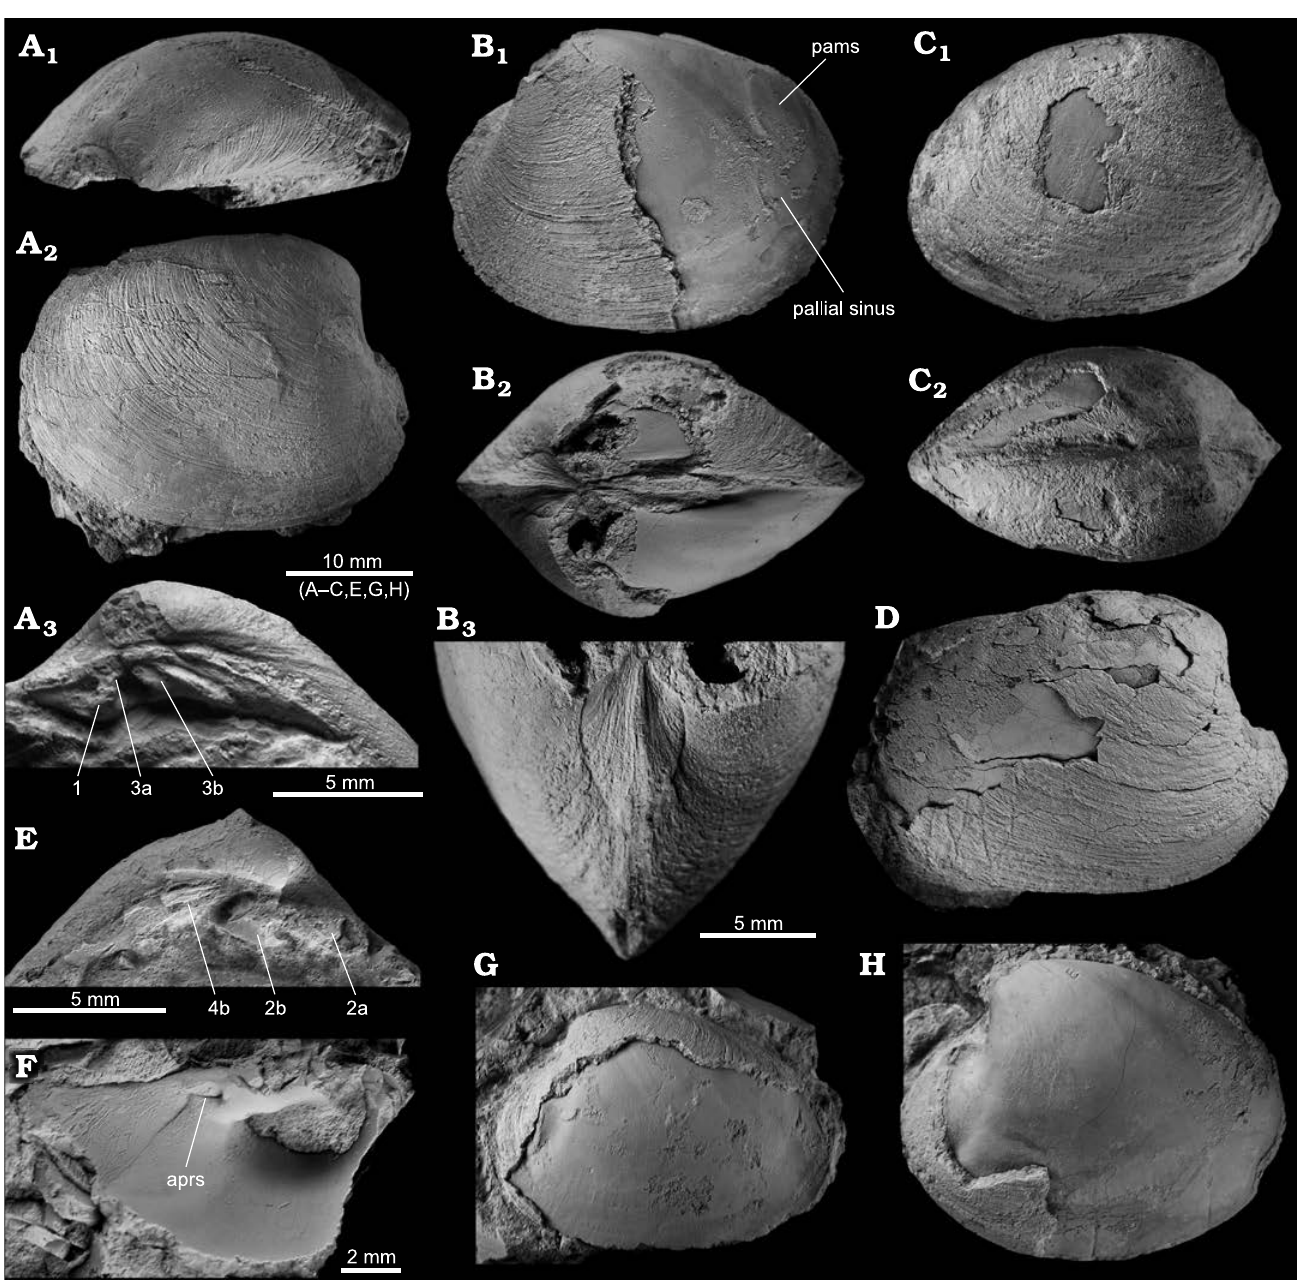
Fig. 12. The vesicomyid bivalve Pliocardia ballesterosi sp. nov. from Upper Miocene seep deposits of the Amlang Formation in Pangasinan province, Luzon, Philippines. A . NIGSPAL-025, holotype, an isolated RV with preserved hinge, in apical view showing lunular incision (A 1 ), view on outer shell showing sculpture and outline (A 2 ), and close-up on hinge with cardinal teeth numbers indicated (A 3 ). B . NRM Mo 192552, paratype, articulated spec- imen with partially removed shell, view on LV showing pallial sinus and pams (B 1 ), in apical view showing strong inflation (B 2 ), close-up on anterior side showing lunular incision (B 3 ). C . NRM Mo 192550, paratype, articulated shell with only moderate inflation, view on RV (C 1 ) and apical view (C 2